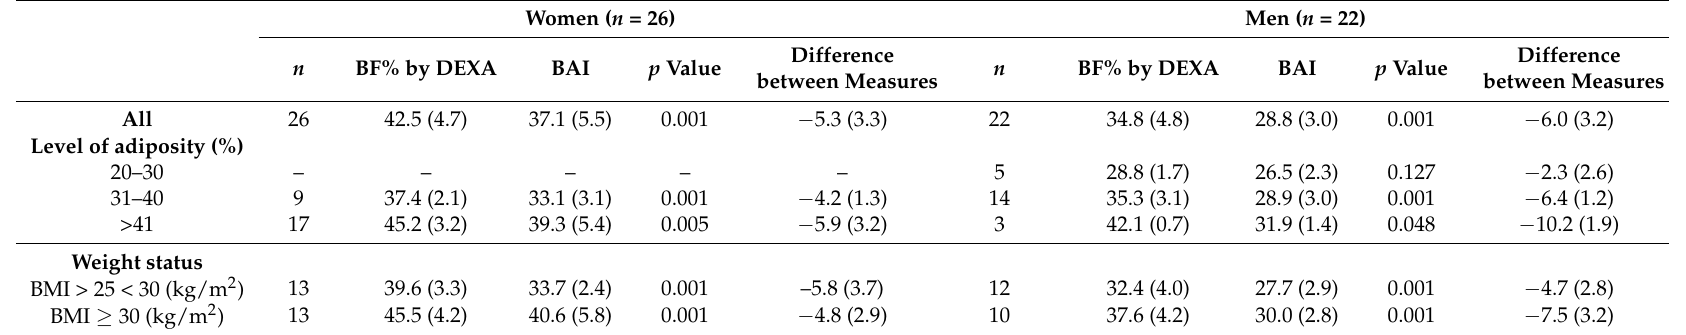
Table 3. BF% by DEXA and BAI according to different levels of adiposity by